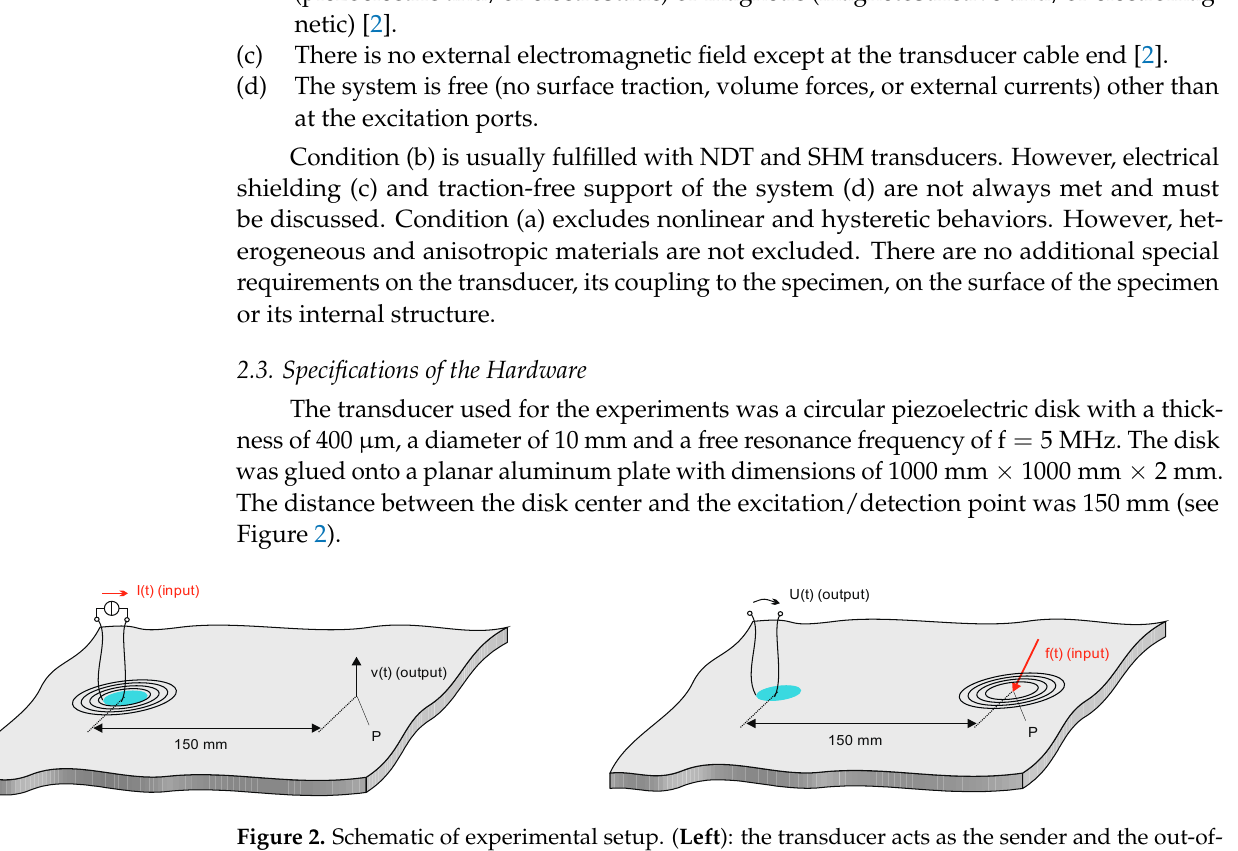
Figure 2. Schematic of experimental setup. ( Left ): the transducer acts as the sender and the out-of- plane velocity is measured. ( Right ): the transducer acts as a receiver, the plate is excited by a point force, and the voltage response under open-circuit conditions is measured. The dimensions of the plate are 1000 mm × 1000 mm × 2 mm.